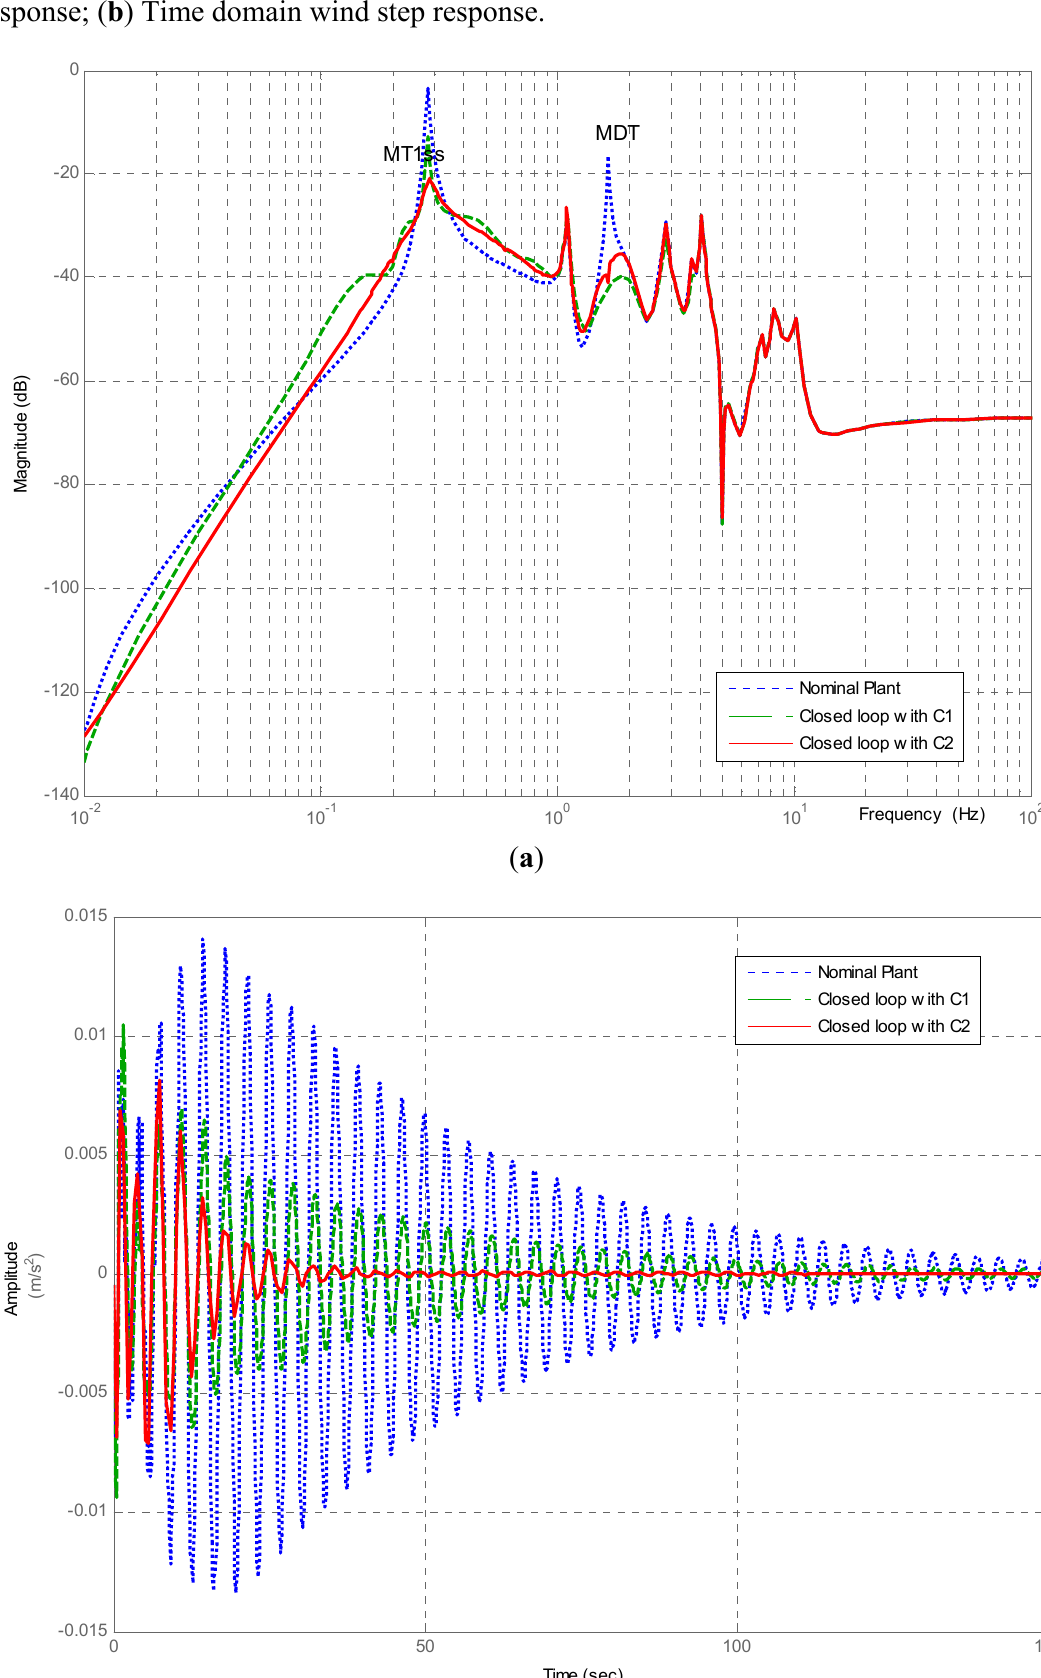
Figure 14. Tower top side-to-side acceleration response for a wind input ( a ) Frequency response; ( b ) Time domain wind step